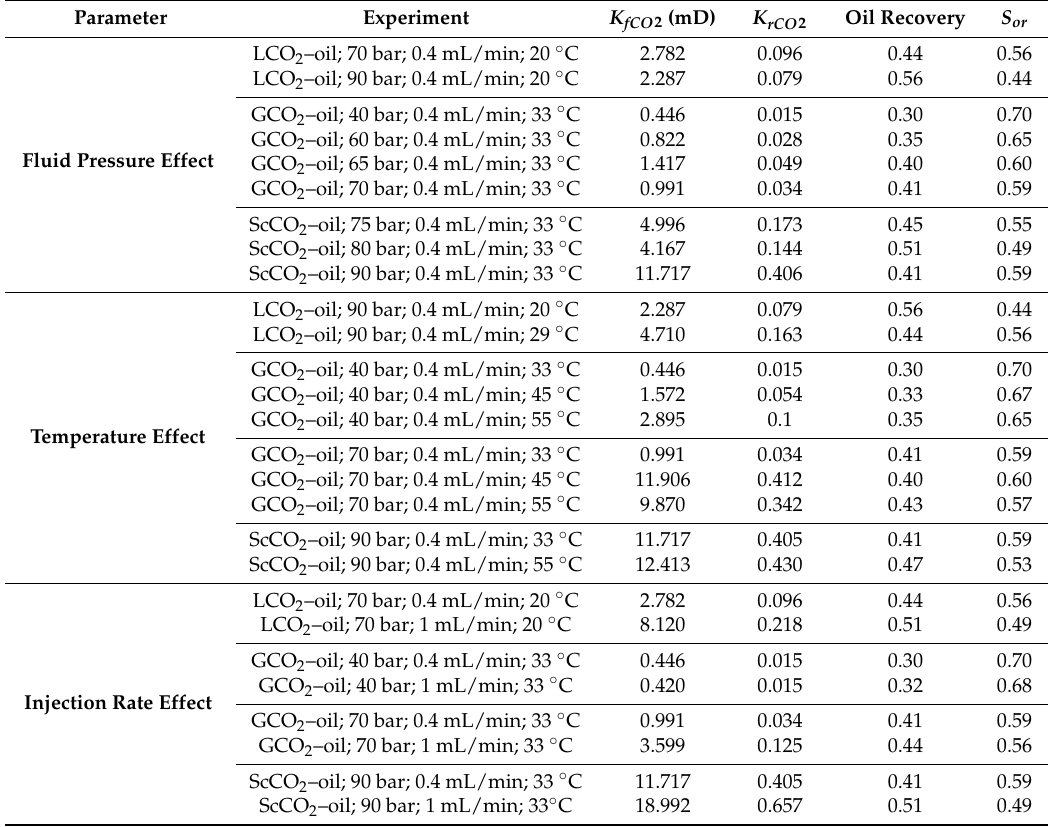
Table 1. Effect of fluid pressure, temperature and injection rate on the endpoint CO 2 effective (relative) permeability and oil recovery as a function of CO 2